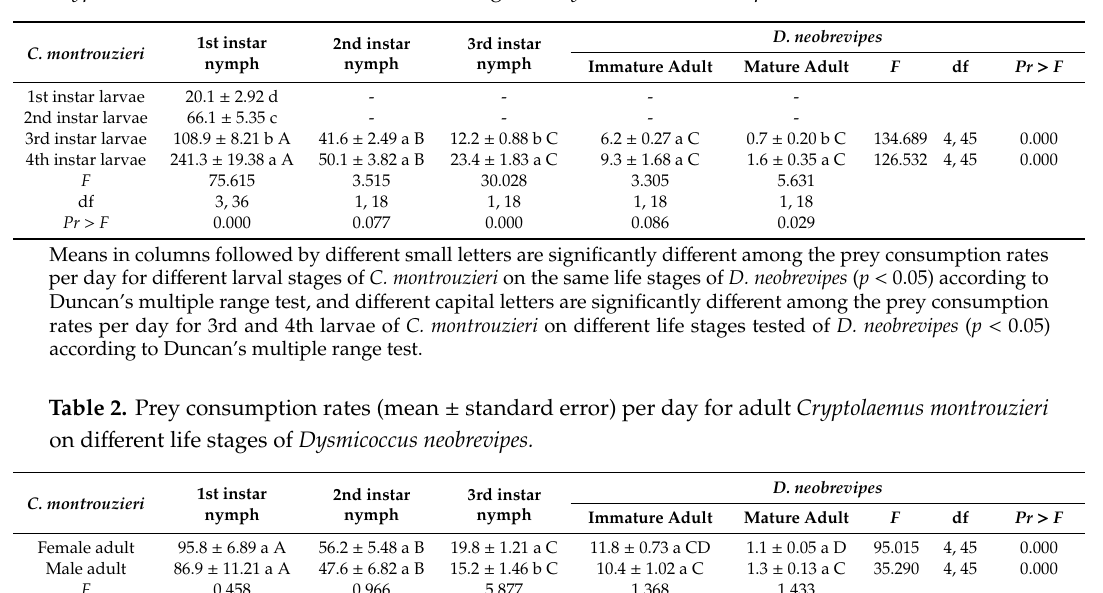
Table 1. Prey consumption rates per day (mean ± standard error) for di ff erent larval stages of Cryptolaemus montrouzieri on di ff erent life stages of Dysmicoccus neobrevipes.